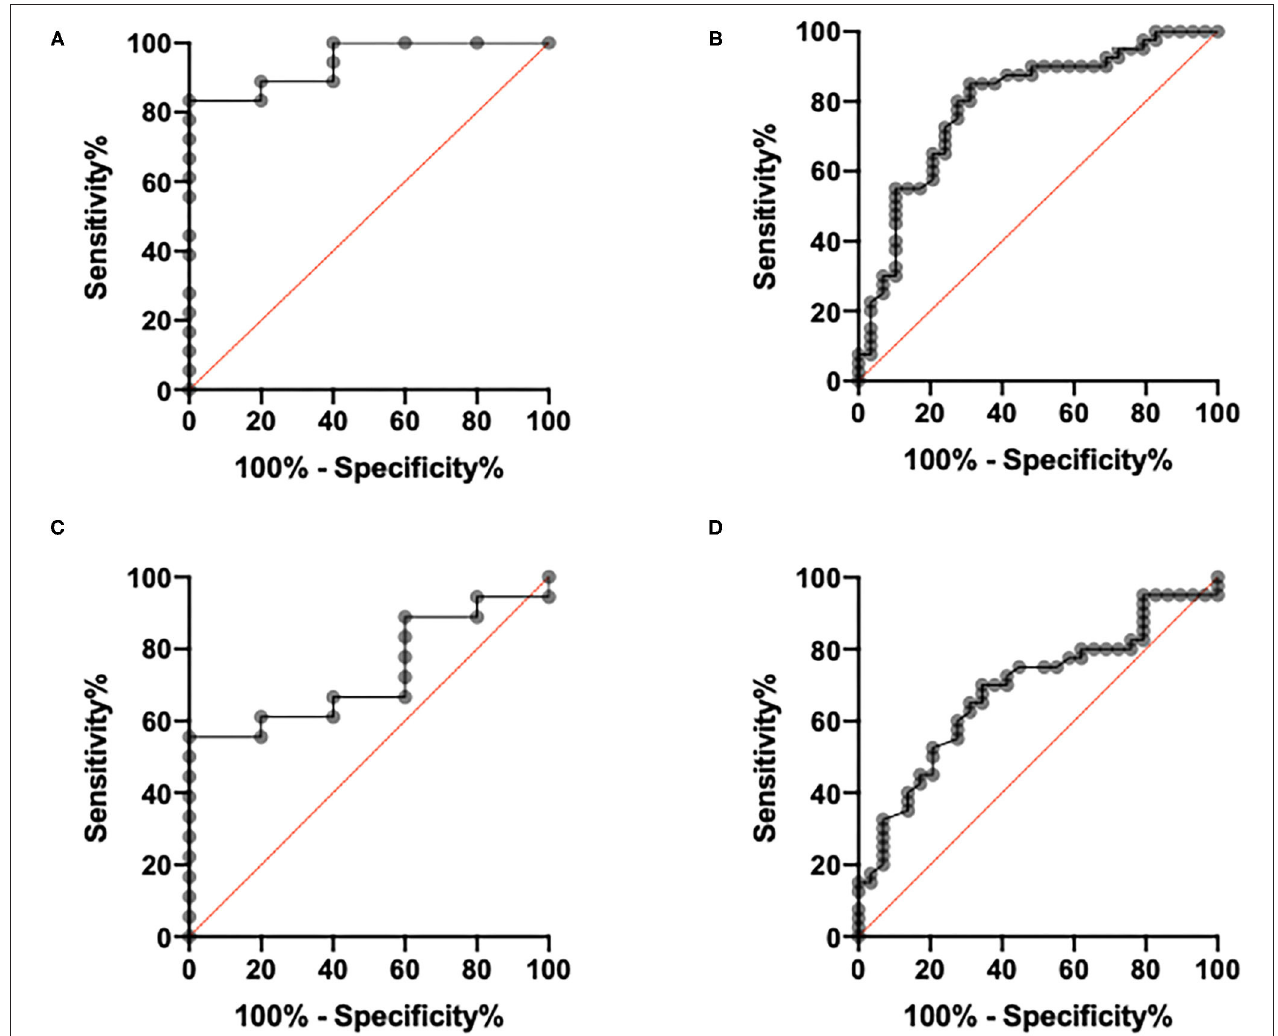
FIGURE 6 | Receiver operating characteristic curves per vessel analysis and per patient analysis. (A) Per patient analysis, based on global myocardial flow reserve (MFR). (B) Per vessel analysis, based on regional MFR. (C) Per patient analysis, based on global stress myocardial blood flow (MBF). (D) Per vessel analysis, based on regional stress